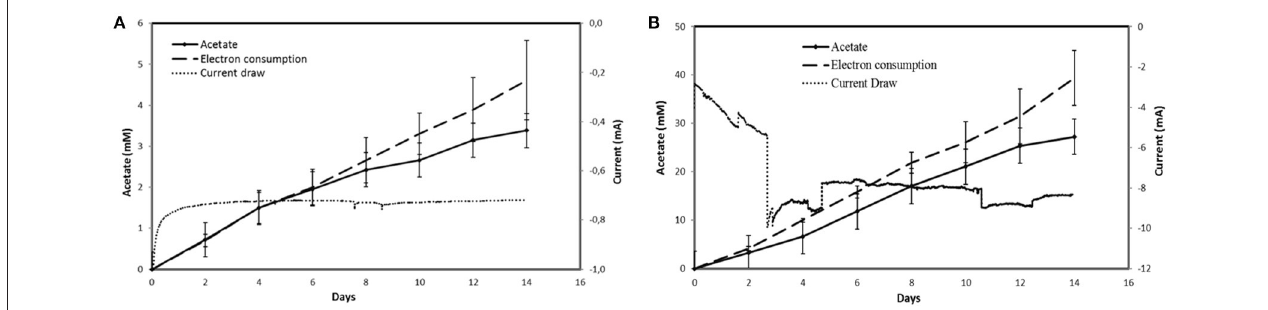
FIGURE 3 | Acetate production, electron consumption and current draw with (A) unmodified carbon cloth cathode and (B) PEDOT:PSS-carbon cloth cathode. Electron consumption curves correspond to the acetate concentration in mM if all the electrons transferred were converted to acetate. Acetate production curves in mM correspond to the real progression of acetate concentration in the MES reactor detected by HPLC. Results shown for acetate production and electron consumption are in triplicate. Current draw curves are from a representative example of three replicate MES reactors.